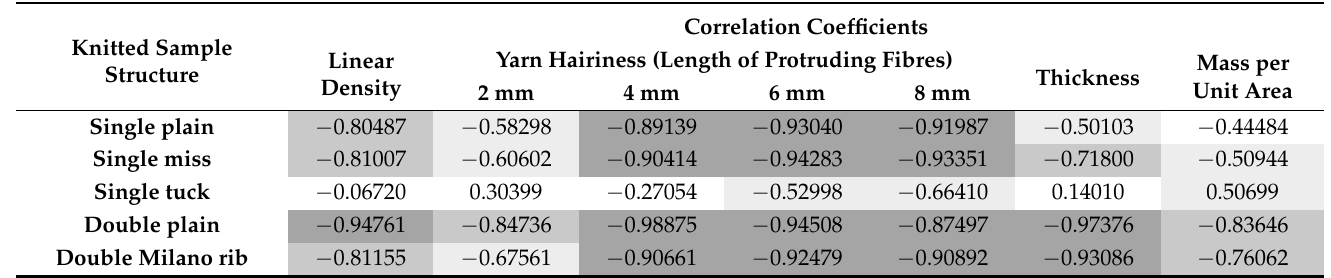
Table 9. The correlation coefficients between air permeability and selected yarn and fabric